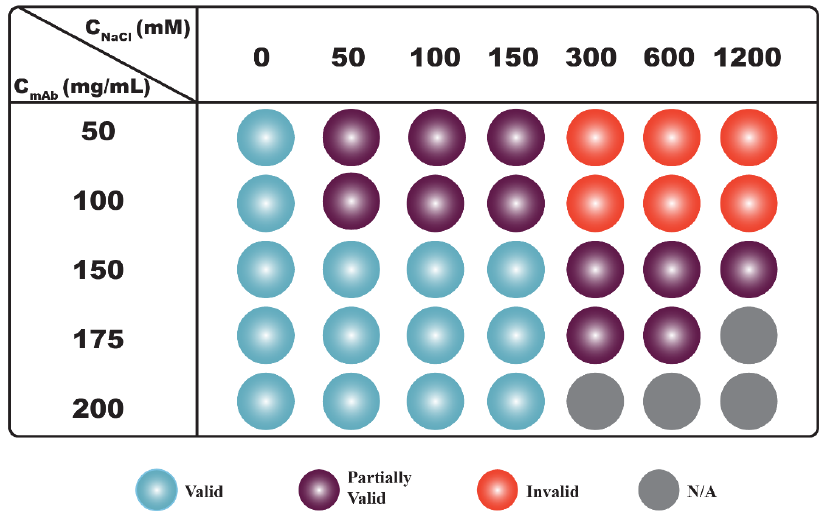
as C NaCl increased to ≥ 300 mM since the S (0) eff values demonstrated a monotonic change across 1 with varying C mAb . The S (0) eff values measured from 50 mg/mL and 100 mg/mL the predicted PPI based on k D values (red spheres in rows 1–2 in Figure 5). When C mAb increased to 150 mg/mL and above, although the S (0) eff values were less than 1, the S (0) eff / S (0) HS values measured from these samples were all well above 1, implying the presence of non-dominating attractive interactions even though the net PPI were repulsive (purple spheres in rows 3–4 in Figure 5).